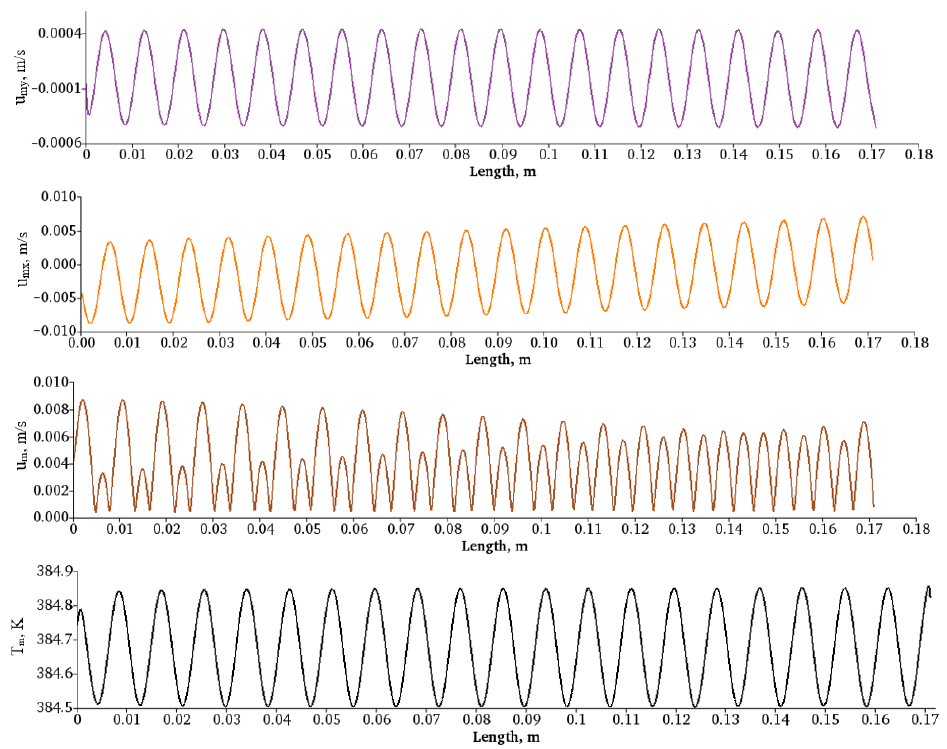
Figure 15. From the top to bottom: changes of the streaming vertical and horizontal components of velocity, streaming velocity magnitude, and mean temperature along the thermometer channel taken at the height y = 0.825 H.